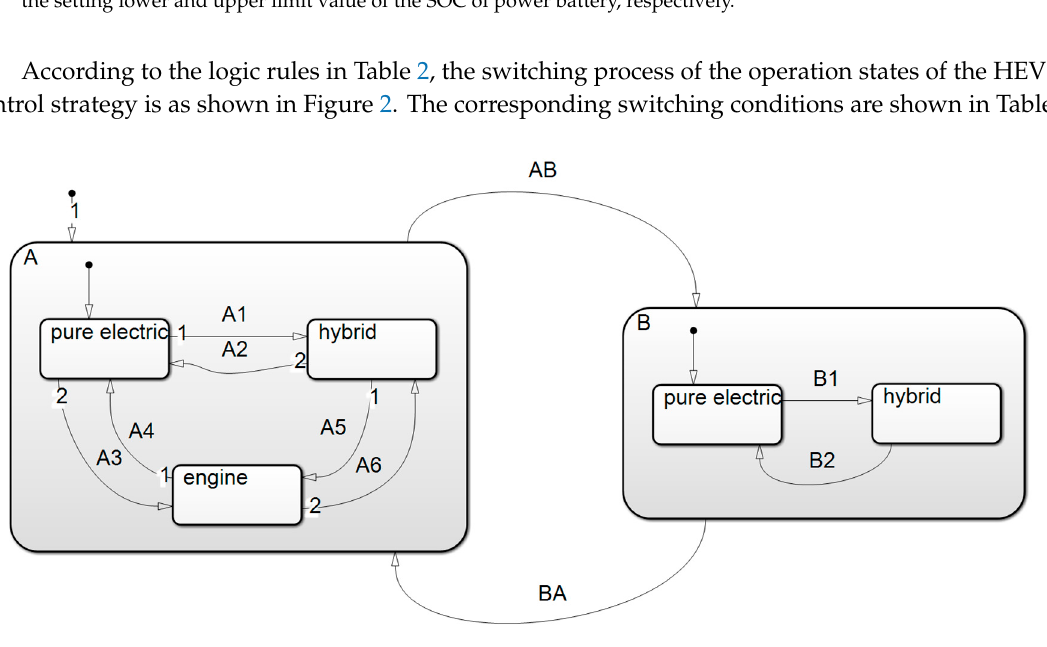
Table 3. The operating state and switching conditions of the rule-based control strategy without the torque coordination.